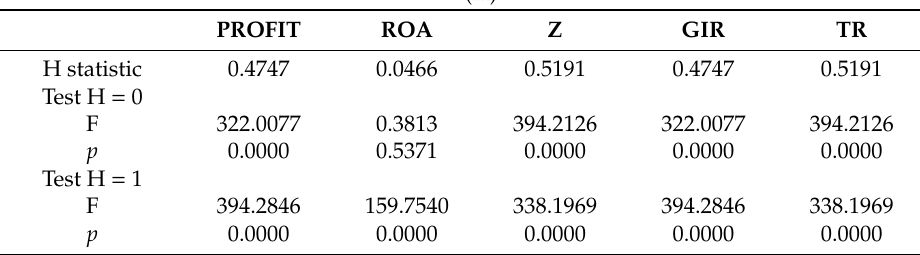
Table A5. H statistics and F tests of H = 0 and H = 1. ( A ) ALL BANKS; ( B ) PUBLIC BANKS; ( C ) PRIVATE BANKS; ( D ) FOREIGN